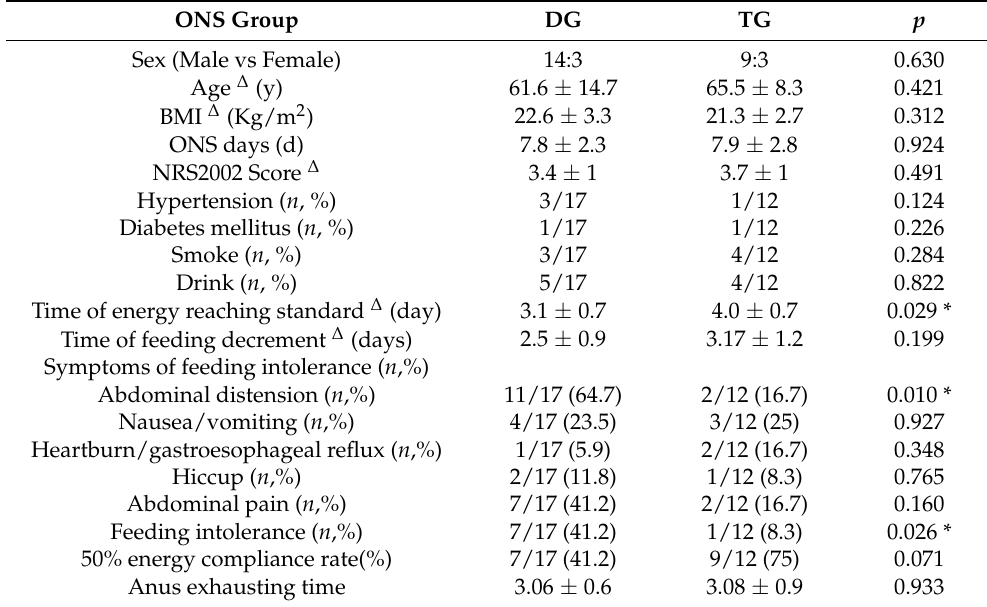
Table 4. The incidence of gastrointestinal intolerance after distal subtotal gastrectomy and total gastrectomy in the experimental